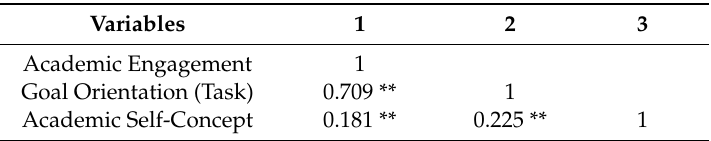
Table 3. Results by correlational analysis of academic engagement, goal orientation (task), and academic self-concept variables.